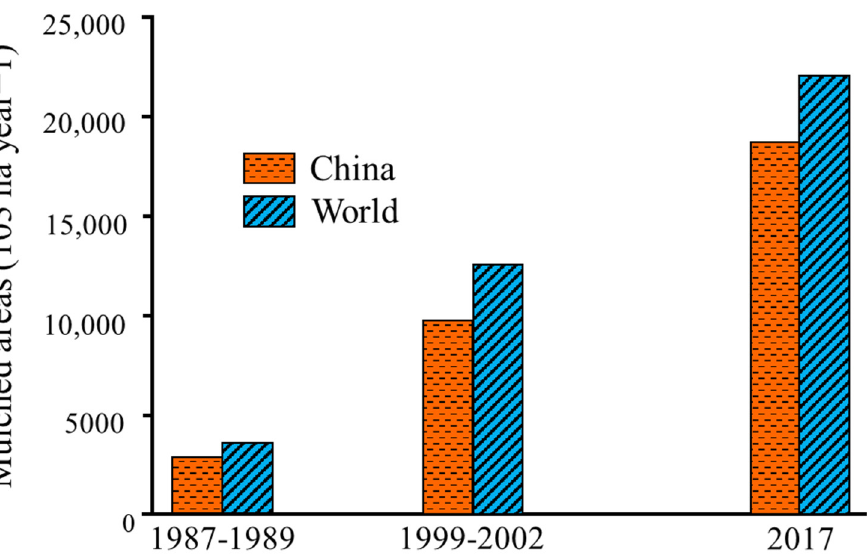
Figure 2. Mulched areas in China and in the world over the 1987–2017 period. Sources: Jensen and Malter [14]; Jouet [15,16]; Castellón [17]; An et al. [18].